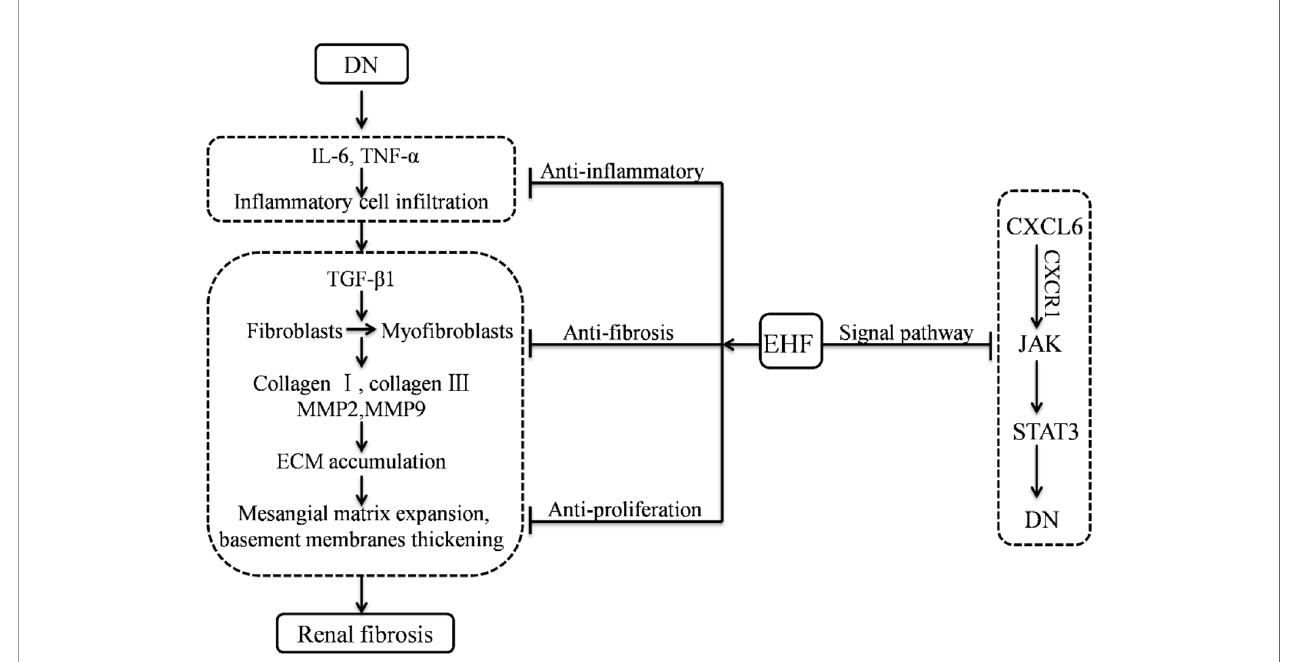
FIGURE 6 | Flow diagram for suggested mechanisms of EHF on